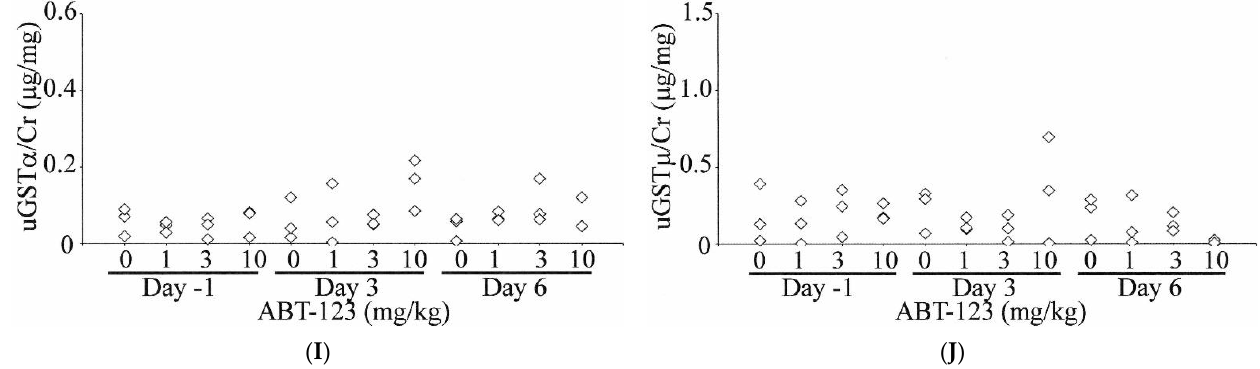
Figure 5. Effect on ABT-123 on urinary biomarkers in rats. Male SD rats were administered with ABT-123 at 0, 1, 3, and 10 mg/kg/day once daily for seven days. Urinary albumin ( A ), β 2-microglobulin ( B ), RPA-1 ( C ), KIM1 ( D ), NGAL ( E ), osteopontin ( F ), clusterin ( G ), trefoil factor family 3 ( H ), GST α ( I ), and GST µ ( J ) were measured at baseline, Day three, and Day six. Each diamond represents an individual animal. Values were normalized to the concurrent urinary creatinine concentration. Table 2. Gene expression changes of urinary biomarkers in glomerular and kidney samples from rats treated with ABT-123 at 10 mg/kg/day for seven days.